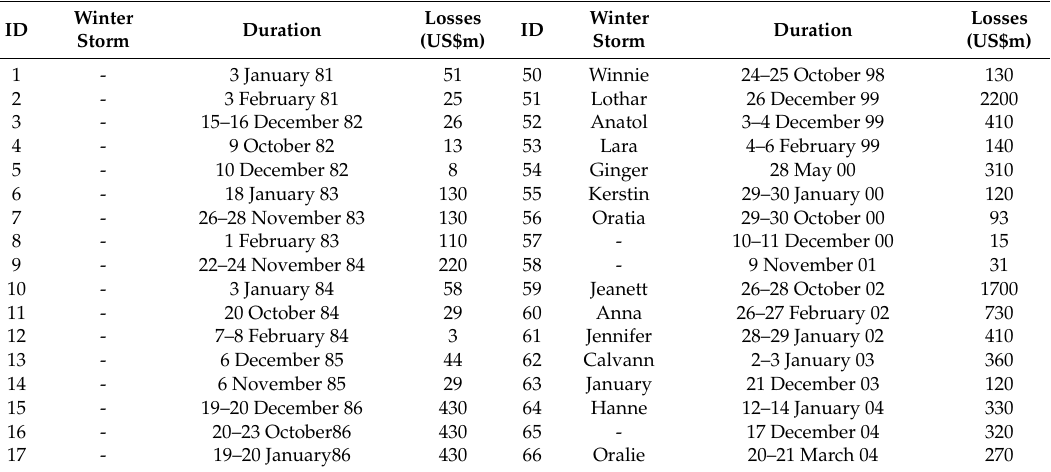
Table 1. Winter storms included in GeWiSA [1]. 100